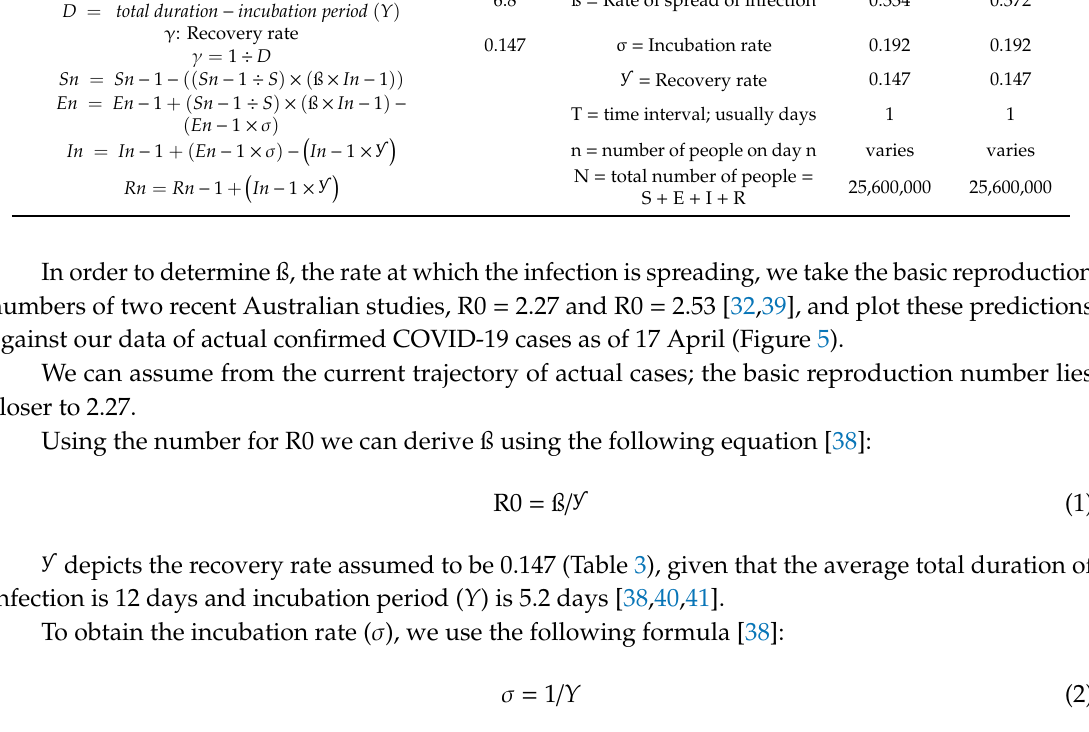
Figure 5. Actual vs. Predicted COVID-19 confirmed cases as of 17 April 2020 .